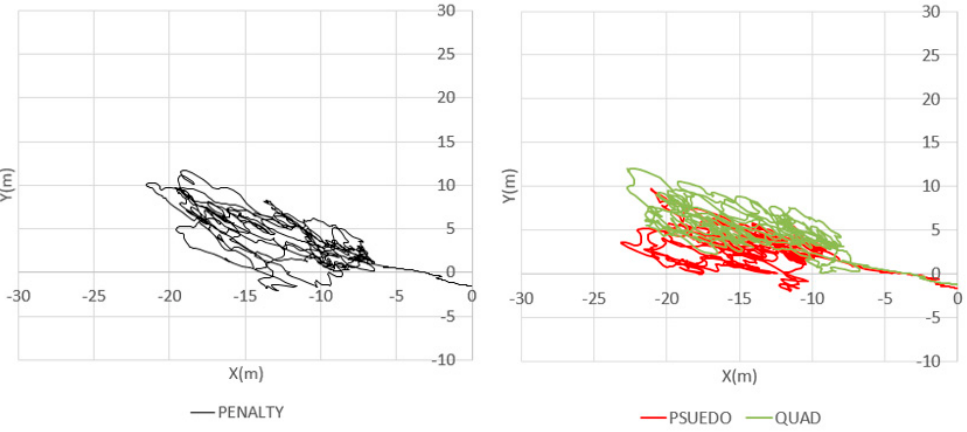
Figure 19 . Surge and Sway Trajectories by Three Different Thrust-Allocation Algorithms. Table 10. Mean Value and Standard Deviation by Three Different Thrust-Allocation Algorithms.